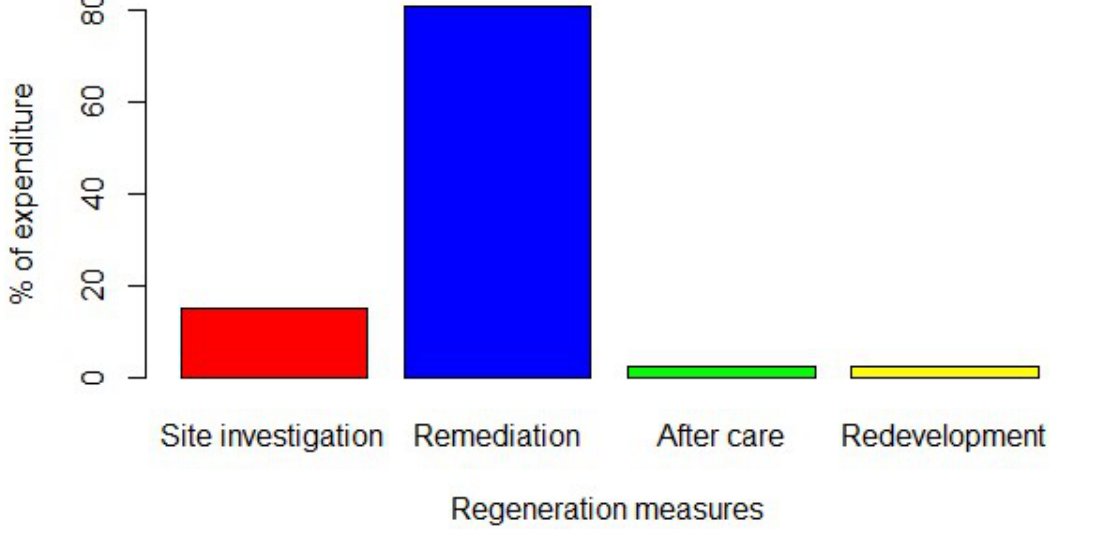
Figure 4. Shares of the total expenditure spent on the management of contaminated sites for different strategies in Europe; selected data for creation of the figure was taken from [104].